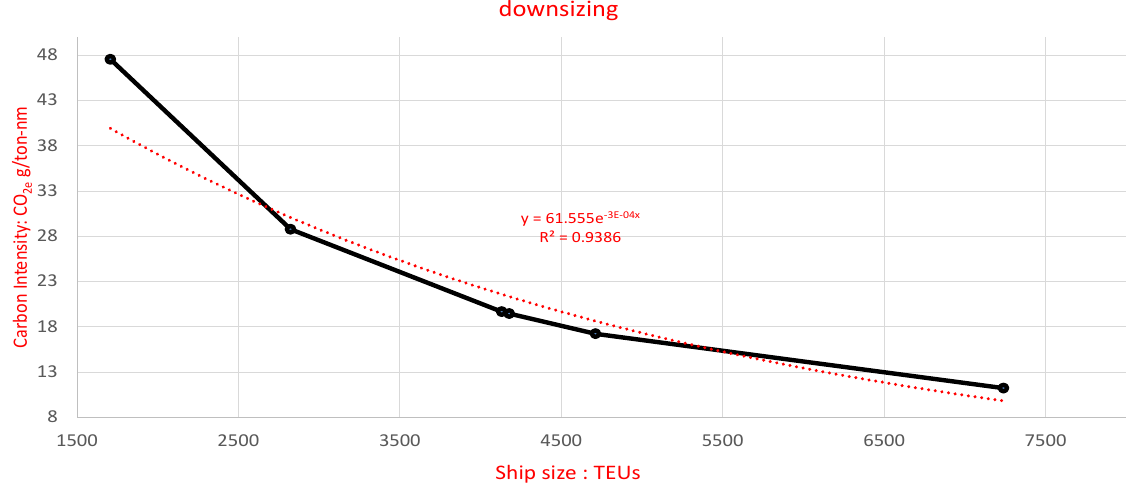
that the deployment of small ships on the Asia–USWC route is not eco-friendly.